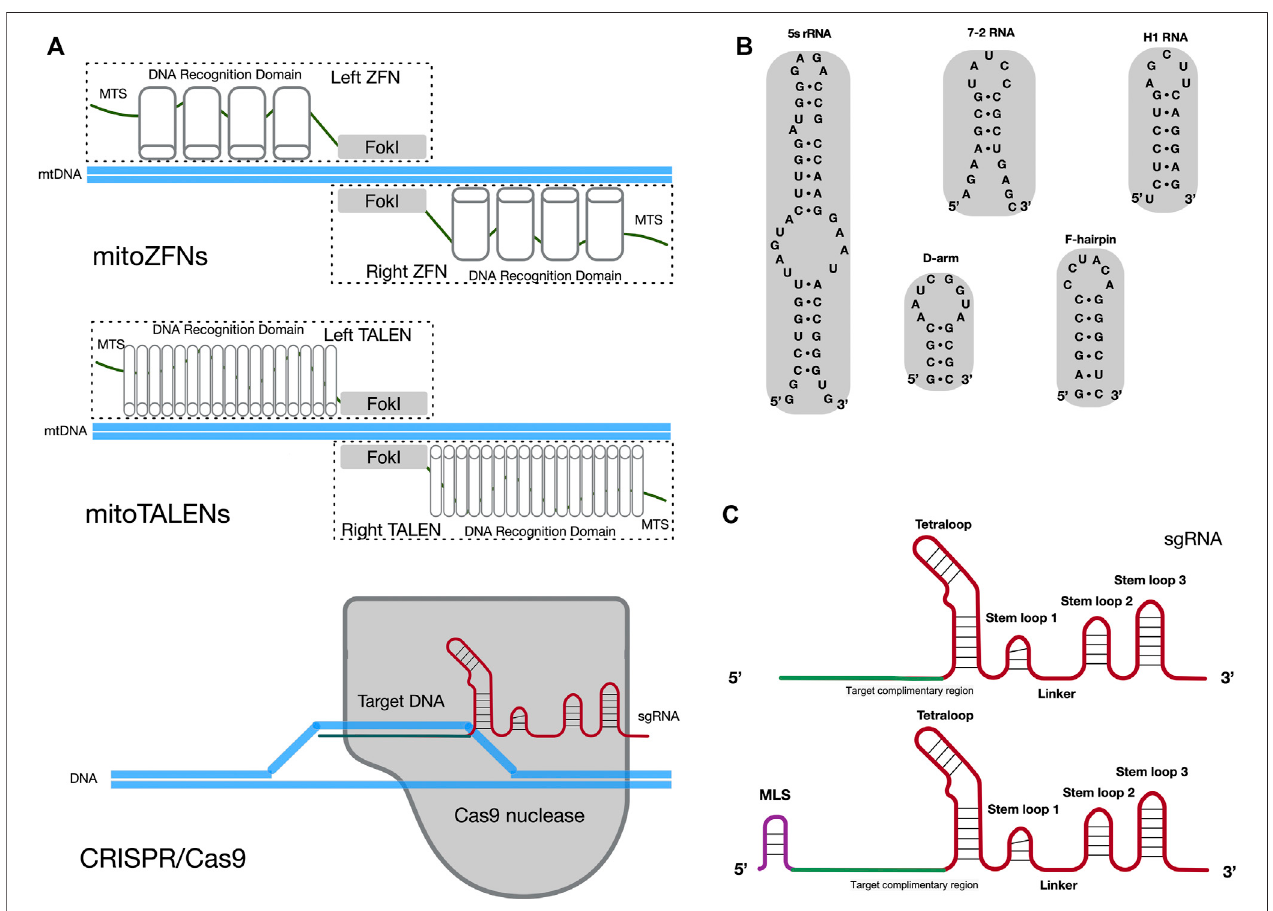
FIGURE 1 | Potential methods for sgRNA importation into mitochondria. (A) Diagram illustrating the cleavage mechanism of mitoZFNs, mitoTALENs and the CRISPR/Cas9system.MTS,mitochondrialtargetingsequence;FokI,non-speci fi cFokInuclease;sgRNA,singleguideRNA. (B) Stem-loopmotifsidenti fi edinhuman5s rRNA, 7-2 RNA, H1 RNA,D-arm and F-hairpin motifs identi fi ed in yeast tRNA Lys (CUU) . (C) The secondary structures of the original sgRNA and sgRNA with MLS. The original sgRNA is comprised of three stem loops and one tetraloop. When compared with the original sgRNA, the potential mitochondria-targeted sgRNA may be have an additional MLS at the 5 ′ -end. The target complimentary region, which the RNA sequence for recognized target DNA, is shown in green. The backbone of the sgRNA is shown in red. MLS is the mitochondrial localization signal and is shown in purple.